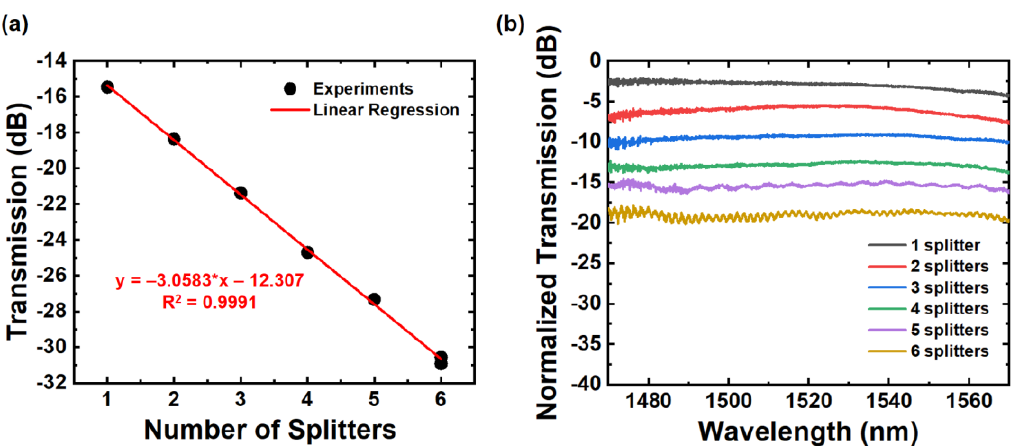
Figure 6. Experimental results ( a ) for excess loss at 1550 nm and ( b ) normalized transmission in broad bandwidth.